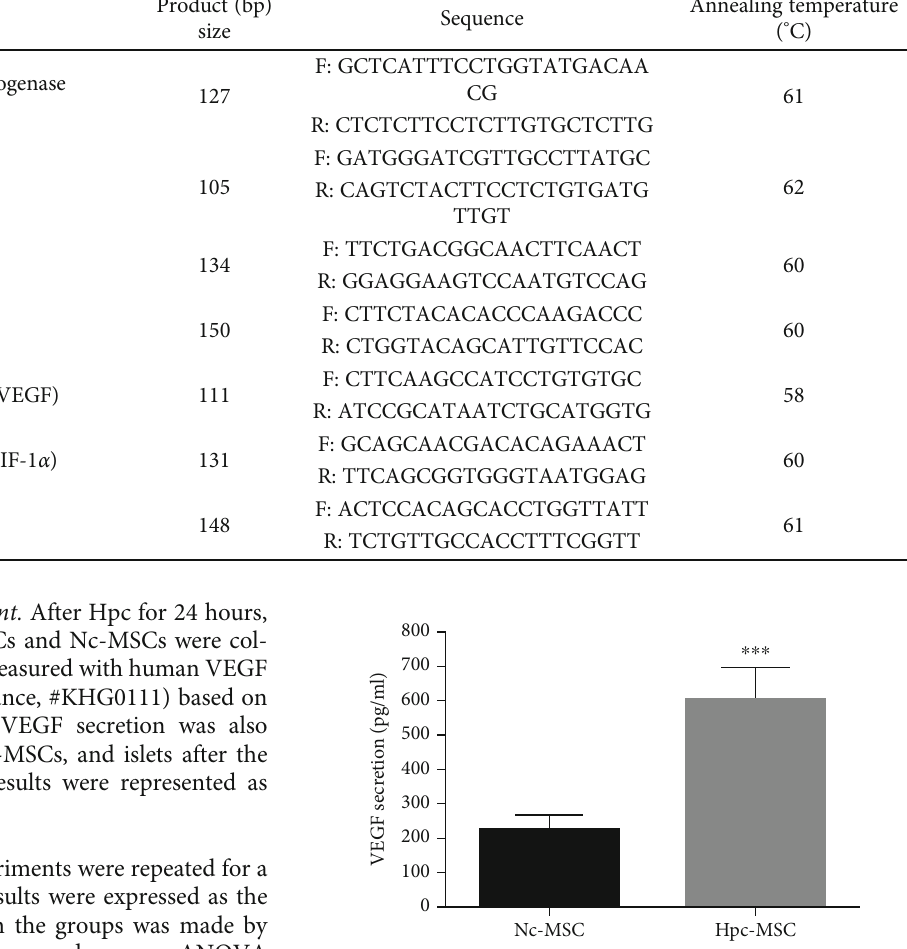
Figure 1: Evaluation of VEGF secretion in Hpc-MSCs compared to Nc-MSCs after 24 hours in hypoxic and normoxia condition. Hypoxia preconditioning increased the VEGF secretion in WJ-